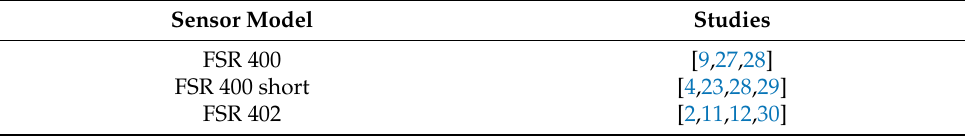
Table 2. The selection of FSR sensors for FMG